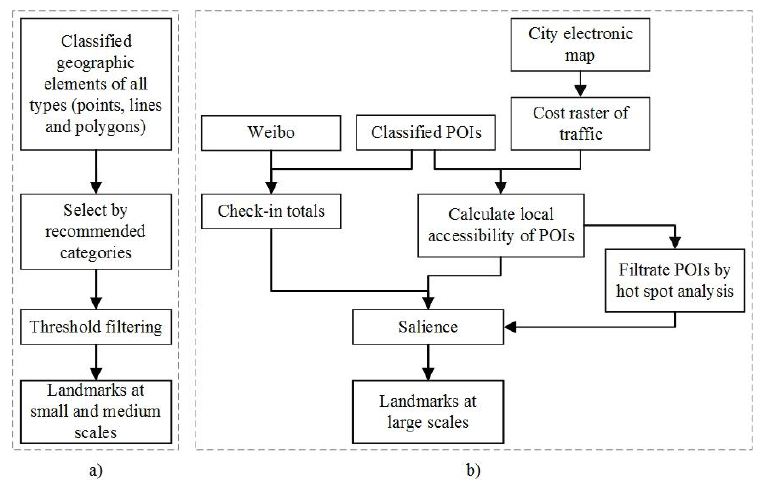
Figure 2. Flow Chart of Urban Landmark Extraction: ( a ) landmarks at small and medium scales; ( b ) landmarks at large scales.